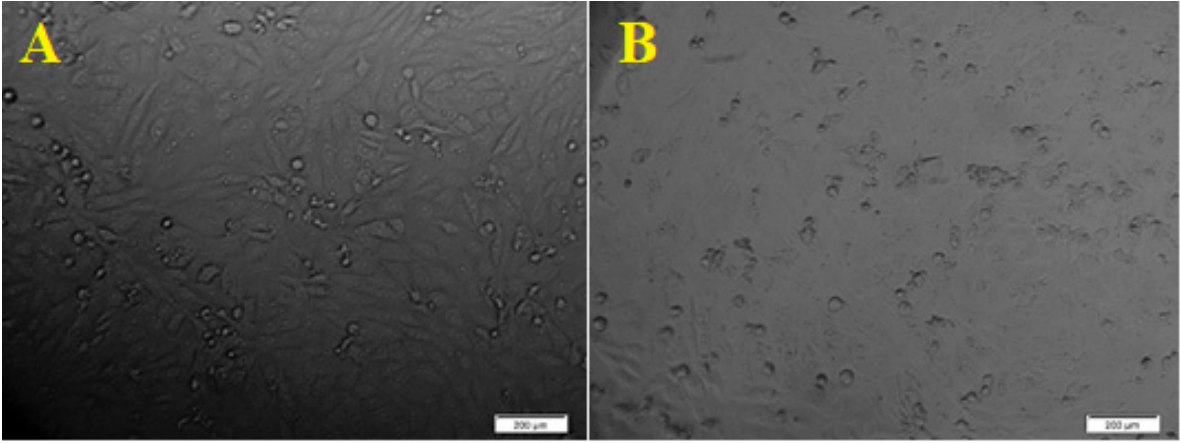
Figure 8. Cancer cell viability percentage on Hep-G2 cell line at various concentrations of ZnO NPs.